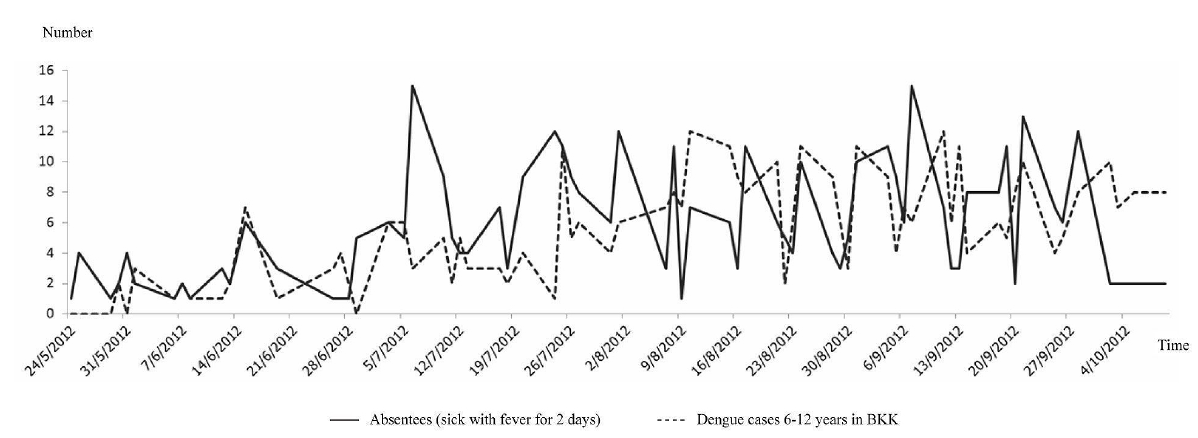
Figure 9. Patterns of daily number of schoolchildren who had fever for 2 consecutive days and daily number of dengue cases during May 24 - October 9, 2012 (first